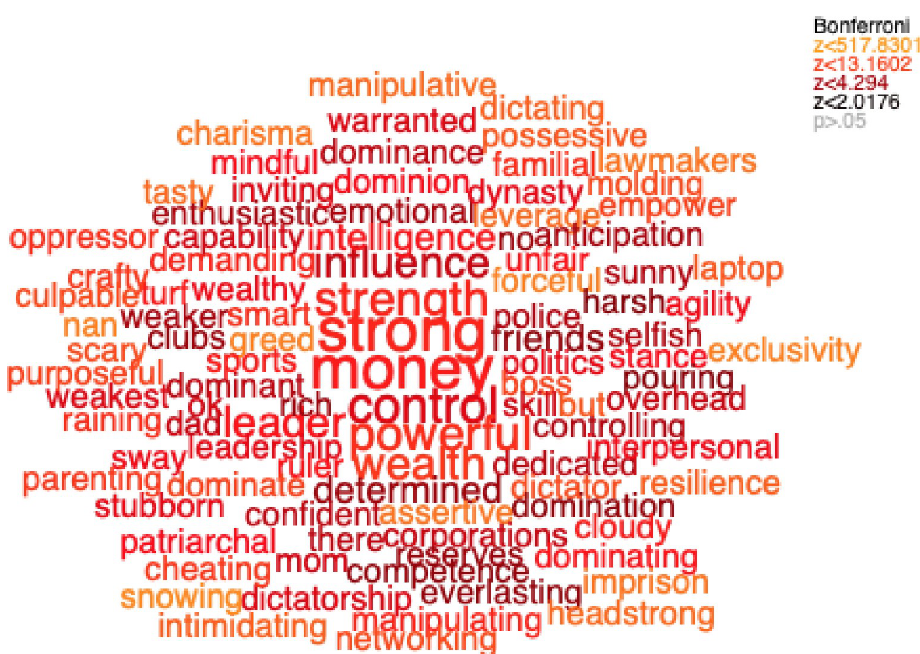
Fig 1. Word cloud describing general of power. Note . The figures were created by a semantic test (see [34] for details) comparing all word responses to the item “Write five keywords describing domains of power”(Set 1) with a random selection of equally many words sampled from the frequency distribution of Google n-grams (Set 2). The semantic test was calculated by measuring the semantic similarity (the cosine of the angle between the vectors) between a word and a vector representing the difference between Set 1 and Set 2 (where the generated words is removed). The length of all vectors is normalized to one. The semantic similarity of each uniquely generated word (Set 1) were compared to the randomly generated words (Set 2) using a t-test, and the color coding of the words indicate the z-value (see legend for coding). Words that were significant following Bonferroni correction for multiple comparisons are colored coded, and words that are significant without correction are printed in gray. Font Sizes are proportional to the square root for the frequency of occurrence of the words in the dataset. The total number of words were 2225, however the figure is limited to the 100 most significant